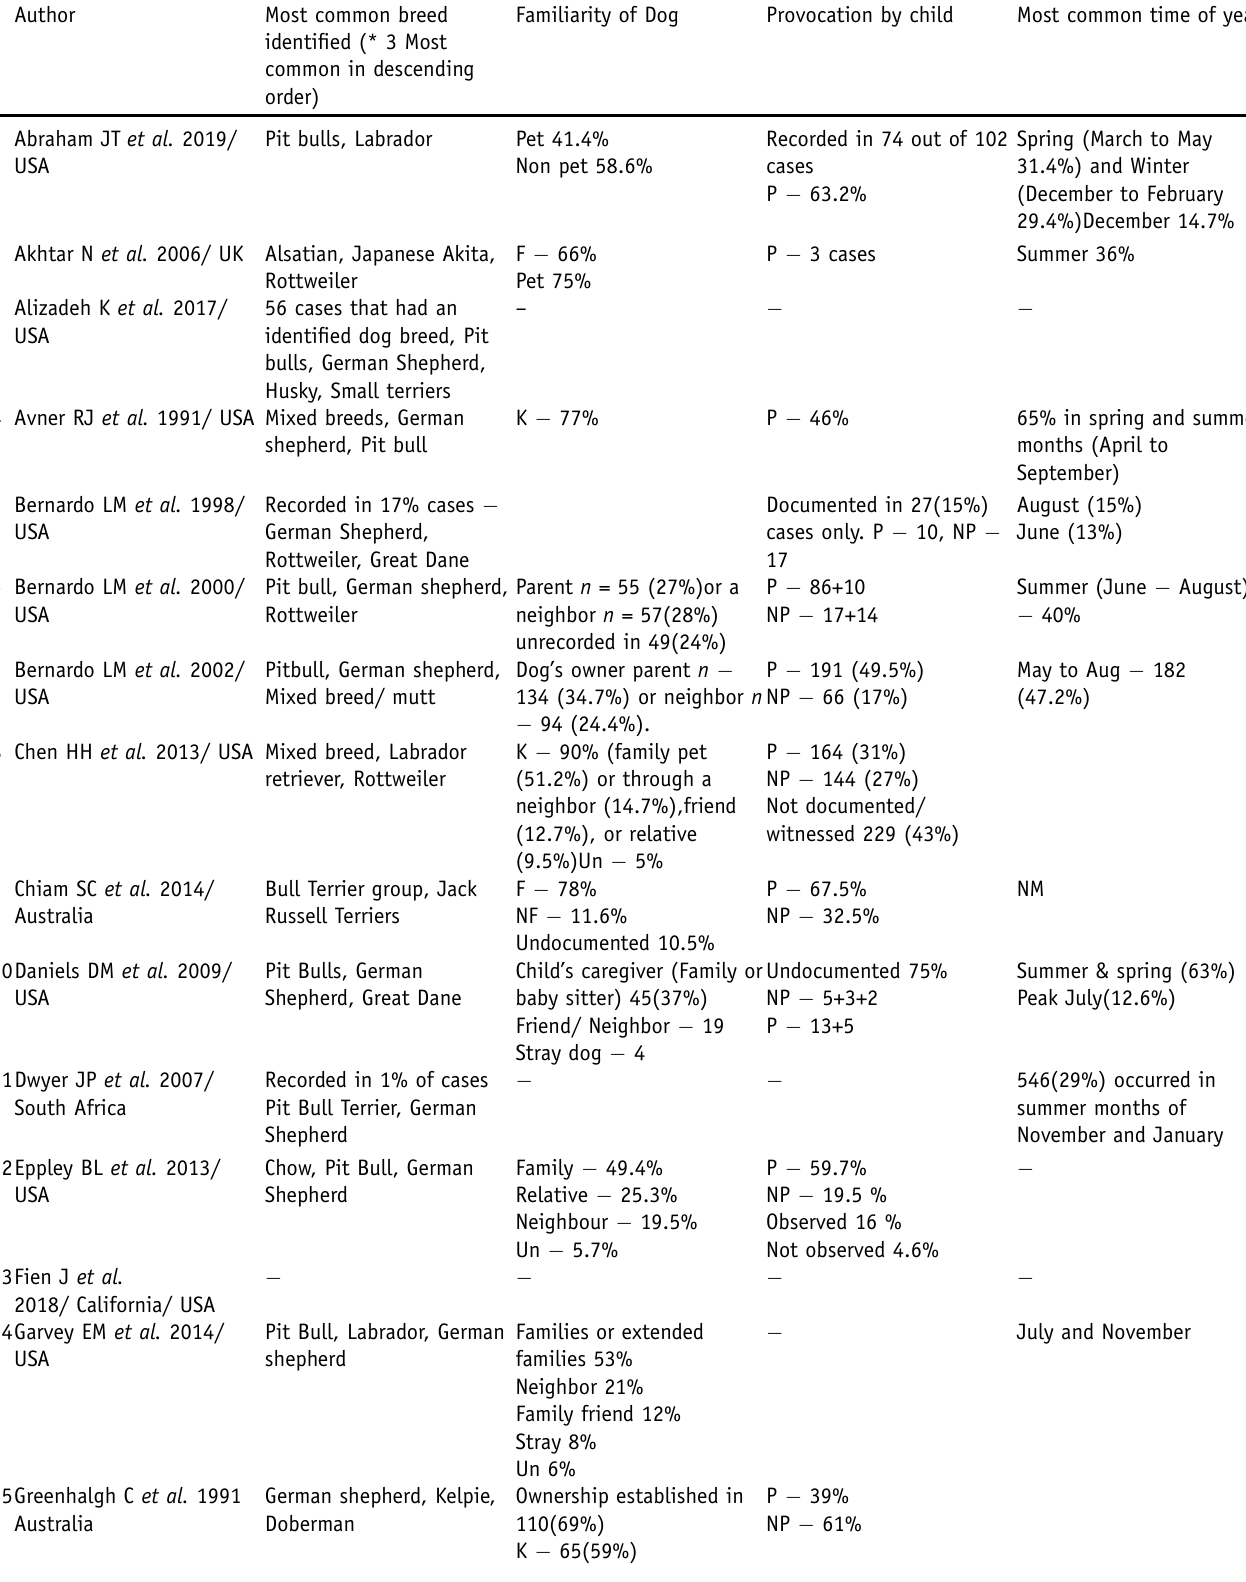
Table II. Characteristics of animals included in